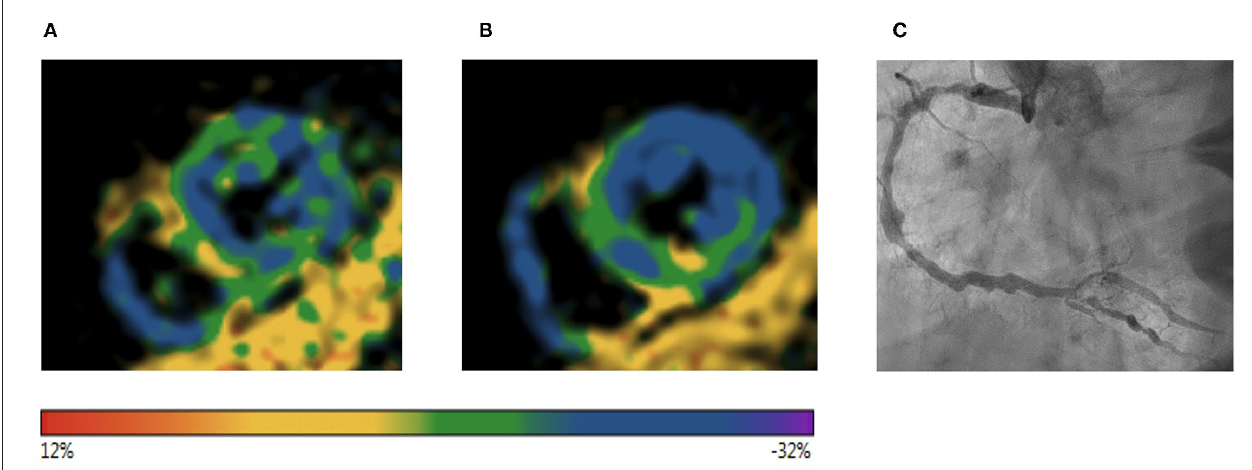
FIGURE 8 | Color-coded fSENC images visualizing longitudinal strain at rest (A) and after DHE (B) of an excluded patient with a positive dobutamine stress test. Invasive coronary angiography revealed a significant stenosis of the right coronary artery (C) (color scale represents regional longitudinal strain). fSENC, fast strain-encoded magnetic resonance imaging; DHE, dynamic handgrip